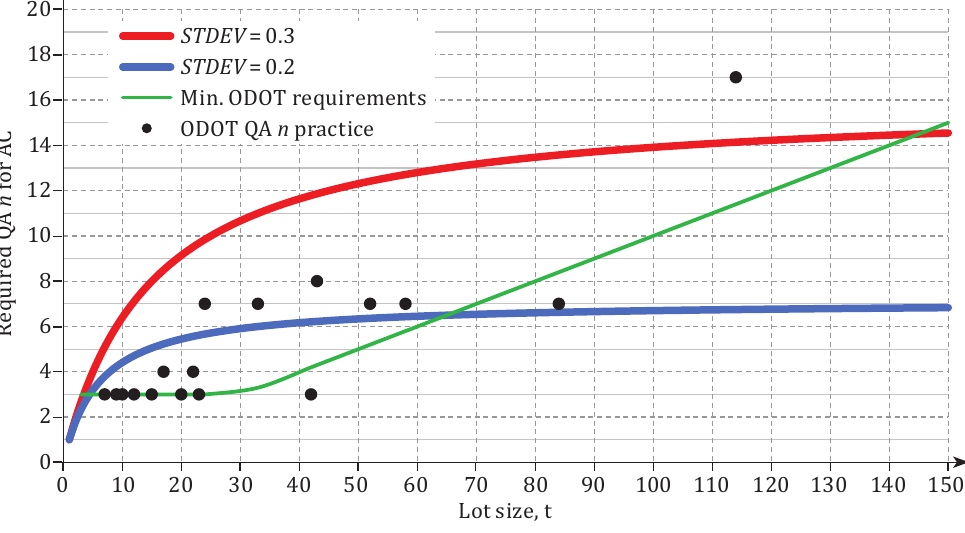
Figure 2. Required QA n for